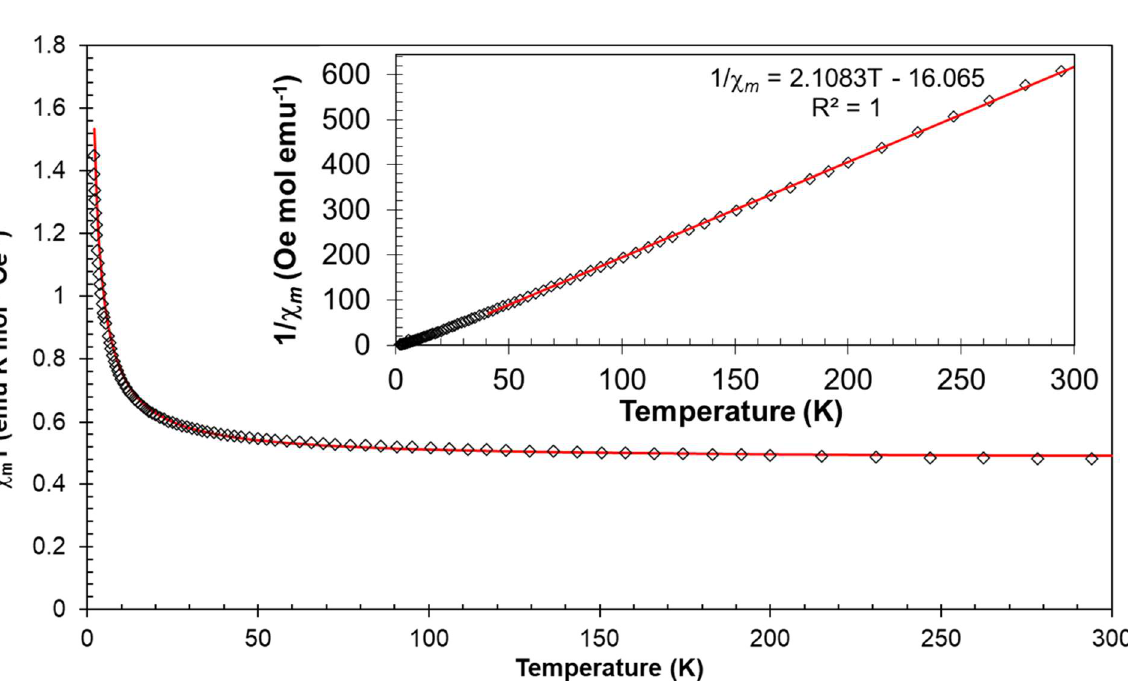
Figure 2. Temperature dependence of χ m T for 1. The red solid line represents the best fit to the uniform Heisenberg 1D-ferromagnetic chain model. The inset displays the temperature dependence of 1/χ m for 1. The red solid line represents the fit to the Curie–Weiss law (40–300 K).